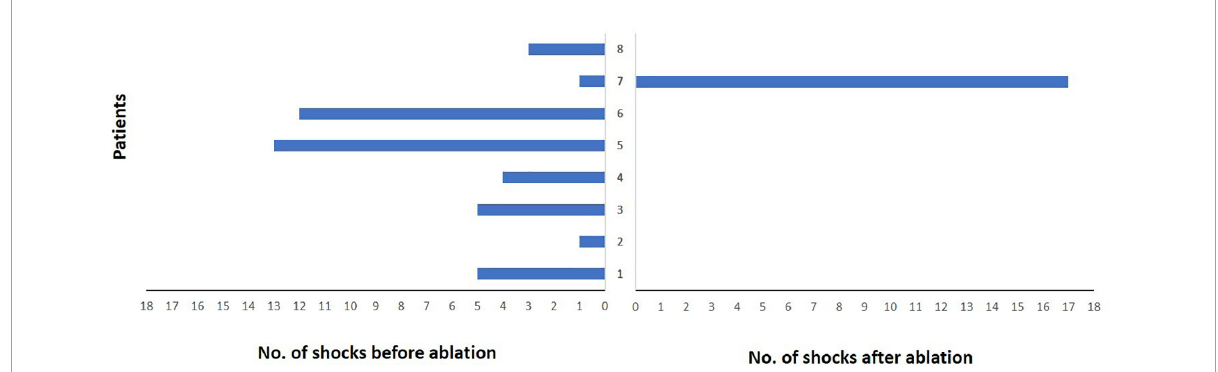
FIGURE4 Burden of implantable cardioverter-defibrillator (ICD) shock delivery per patient during follow-up after ablation. Each patient is represented by a single bar in the diagram. Only one patient did not experience ICD shock reduction due to recurrent ventricular tachycardia storm. However, a significant reduction in the median number of ICD shocks could be observed in the other